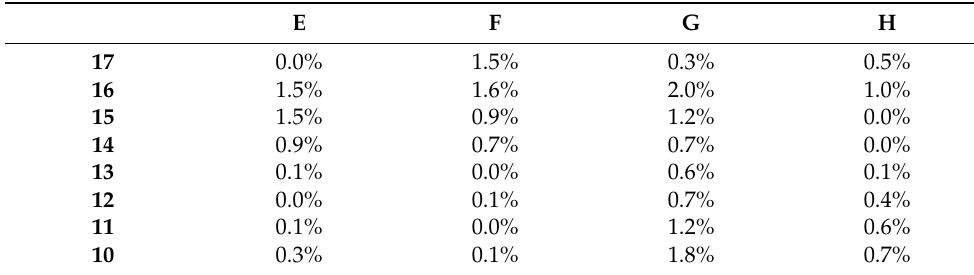
Table 3. Individuation of Class A area in test surface.